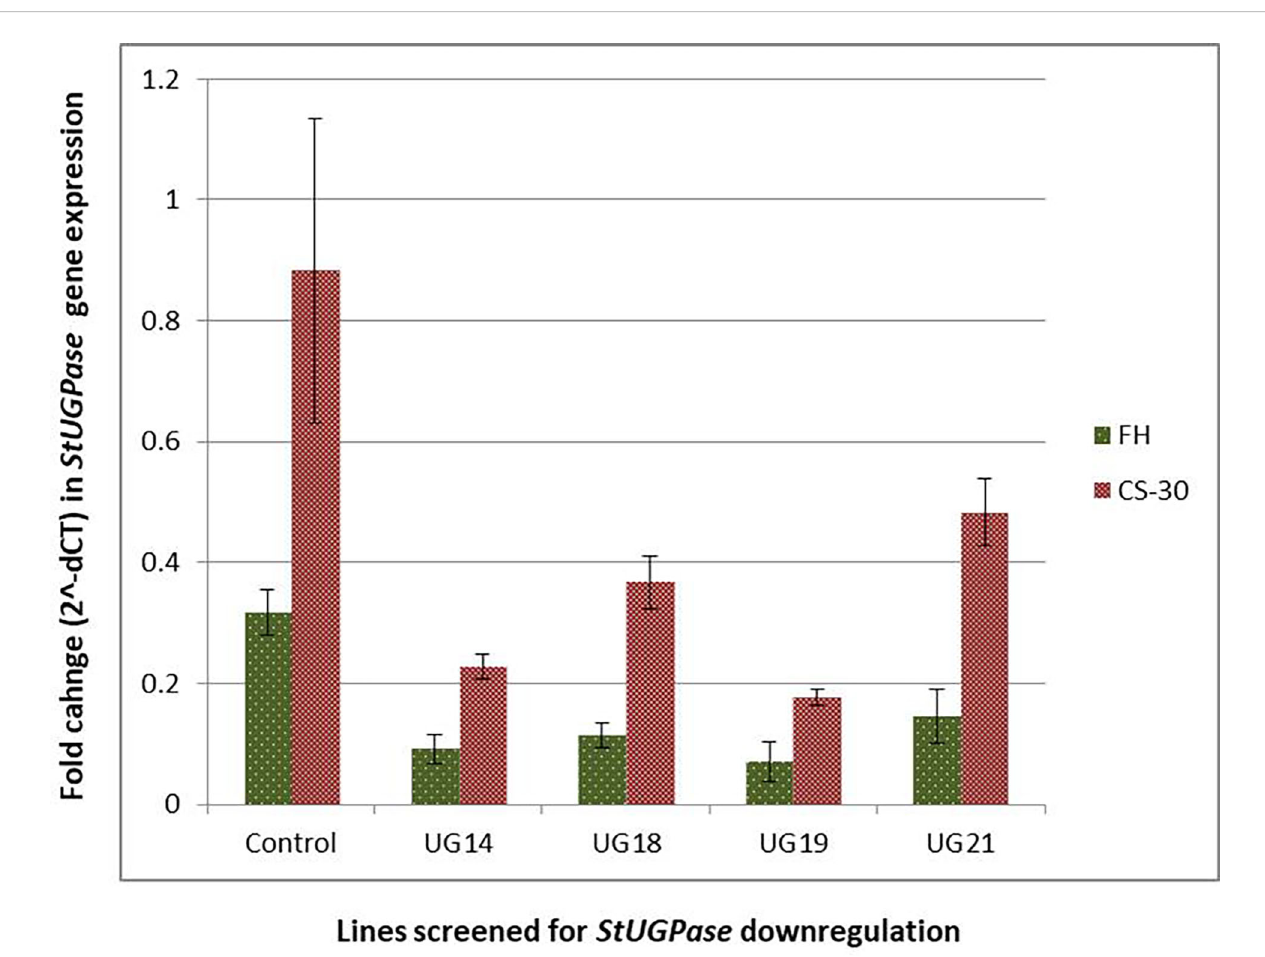
FIGURE 8 Reduction in StUGPase expression in the four RNAi potato transgenic lines of KC4 as revealed by Real-Time PCR analysis. Control, KC4C plant; UG14, UG18, UG19, and UG21 represents RNAi transgenic lines. FH, fresh harvest; CS-30, cold stored for 30